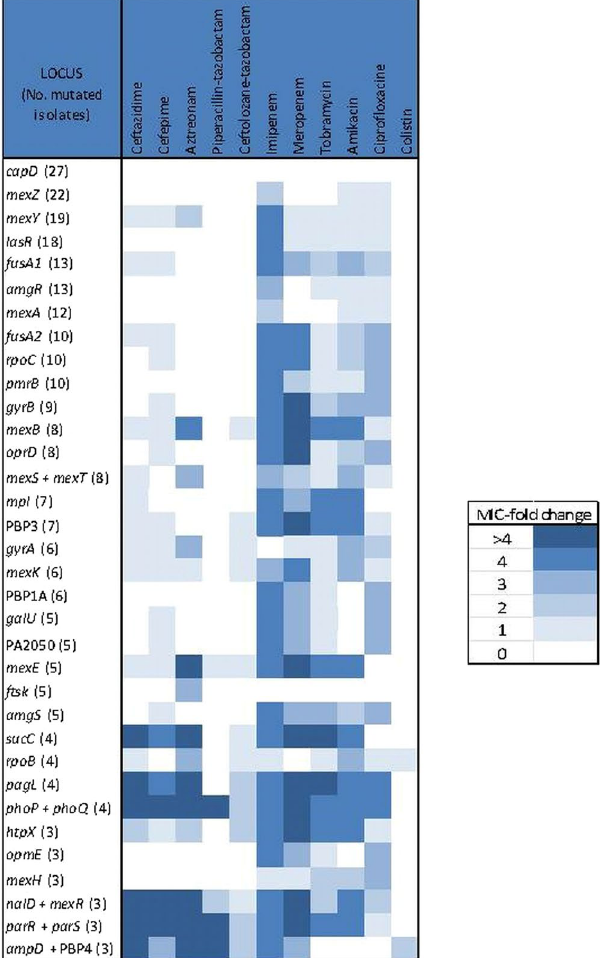
Figure 5. MIC-fold change for each antibiotic tested between isolates mutated or not mutated in a specific gene. To evaluate the implication of the presence of mutations in the main genes possibly related with antibiotic resistance the median MIC for both groups were calculated and compared, results are expressed in MIC-fold change. PA2489, mexW , oprF , parE and nfxB were excluded since the number of mutated isolates were < 3. Some genes were grouped (e.g. ampD and dacB (PBP4) or nalD and mexR ) according to their well-established effects on resistance (e.g. AmpC or MexAB-OprM overexpression,